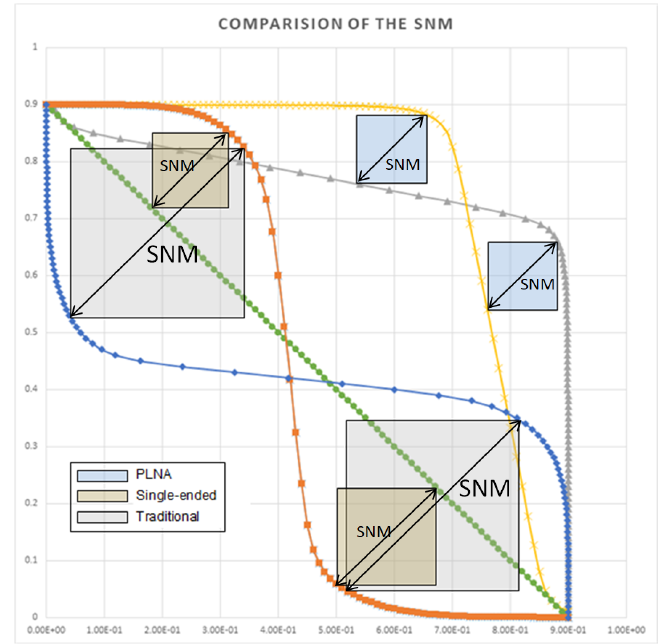
Figure 29. Comparisons of the SNM.